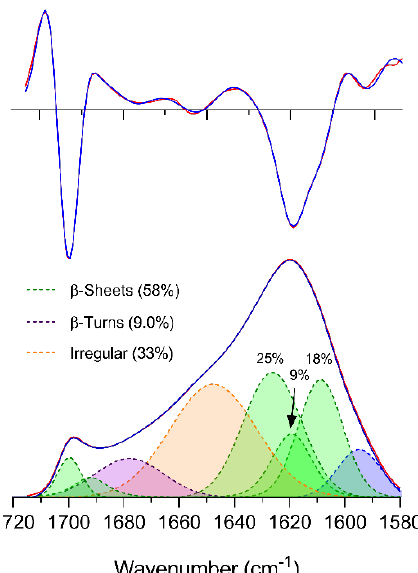
Figure 1. Band fitting of the amide I band and its second derivative of SF fibers. Top: second derivative of absorbance; bottom: ATR absorbance spectrum. Blue: Experimental spectrum and experimental second derivative; Red: fitted spectrum and fitted second derivative. The maximum ATR absorbance was 0.083 at 1620 cm − 1 .